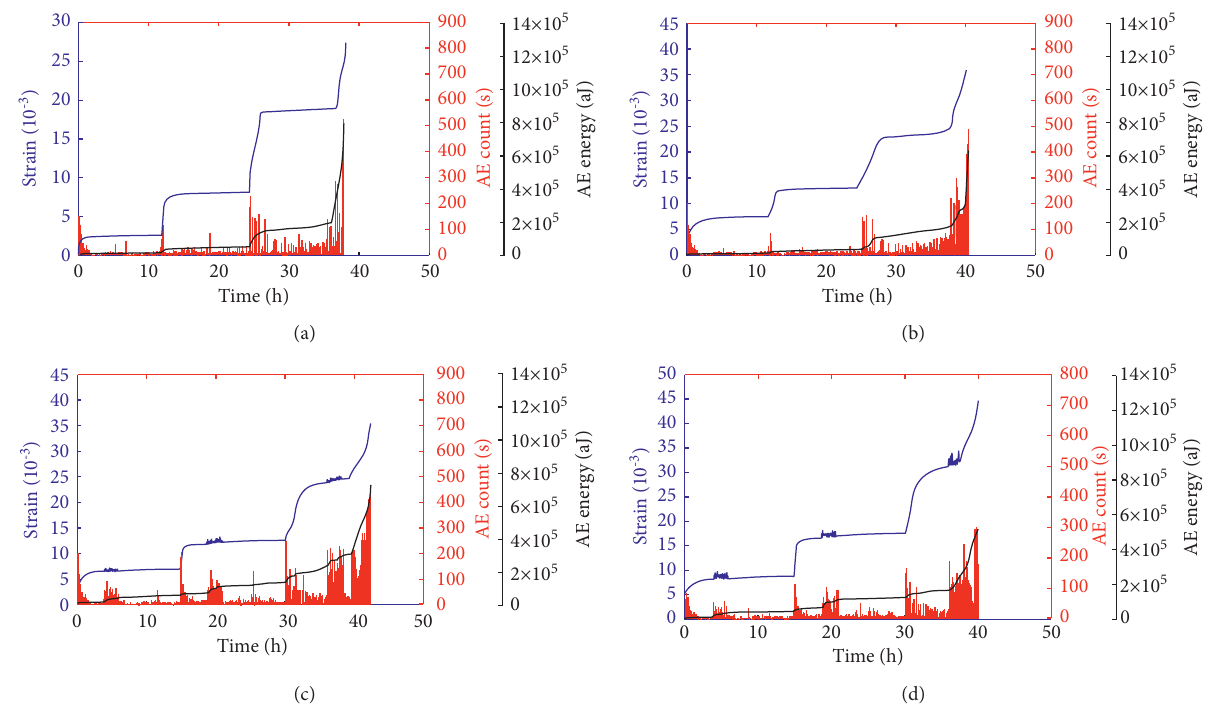
Figure 6: Creep and acoustic emission characteristics of the specimens with different moisture contents under disturbed and undisturbed conditions: (a) 0% moisture content, undisturbed; (b) 5% moisture content, undisturbed; (c) 5% moisture content, disturbed; (d) 10% moisture content,